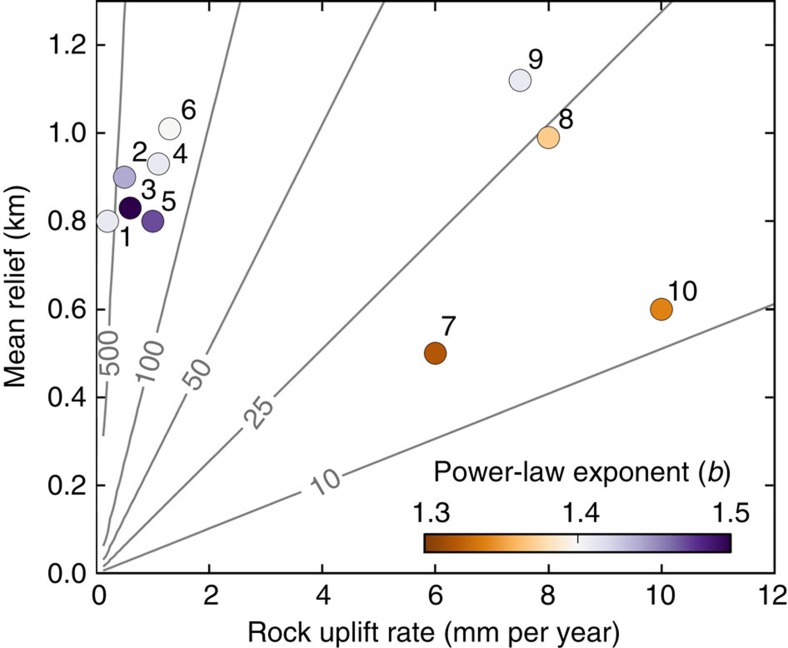
A global perspective on tectonics and valley shape.(a) Rock uplift plotted against average relief of some of Earth's major mountain ranges: Washington Cascades41, WA, USA (1); Coast Mountains42, BC, Canada (2); Fiordland8, New Zealand (3); Greater Caucasus43, Georgia/Russia (4); Northern Patagonian Andes44, Chile (5); European Alps45, Austria/Italy/Switzerland (6); Central Range46, Taiwan (7); Eastern Himalaya47, China (8); Western Himalaya48, Pakistan (9); and High-uplift Westland27, New Zealand (10). Contours indicate time (kyr) necessary to renew 20% of the relief, the average fraction of relief turnover time required to transform a U-shaped into a V-shaped valley in Westland. The minimum, mean and maximum durations of the last four interglacial periods are 20, 22 and 26 kyr, respectively49, indicating that transformation from glacial to fluvial landscape morphology can occur during a single interglacial period for comparable or lower contour values. Power-law exponents indicate the degree of glacial imprint on topography. See Supplementary Fig. 6 for study area maps.